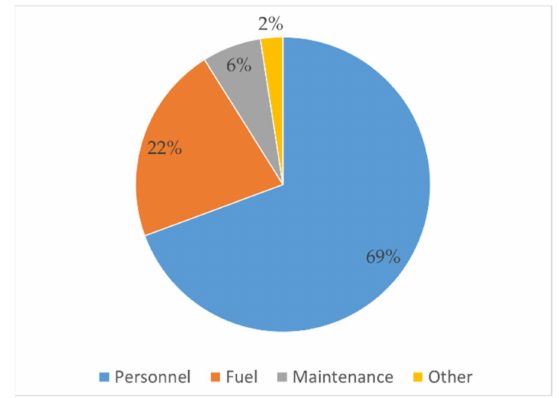
Figure 3. Distribution of expenses—2 m 3